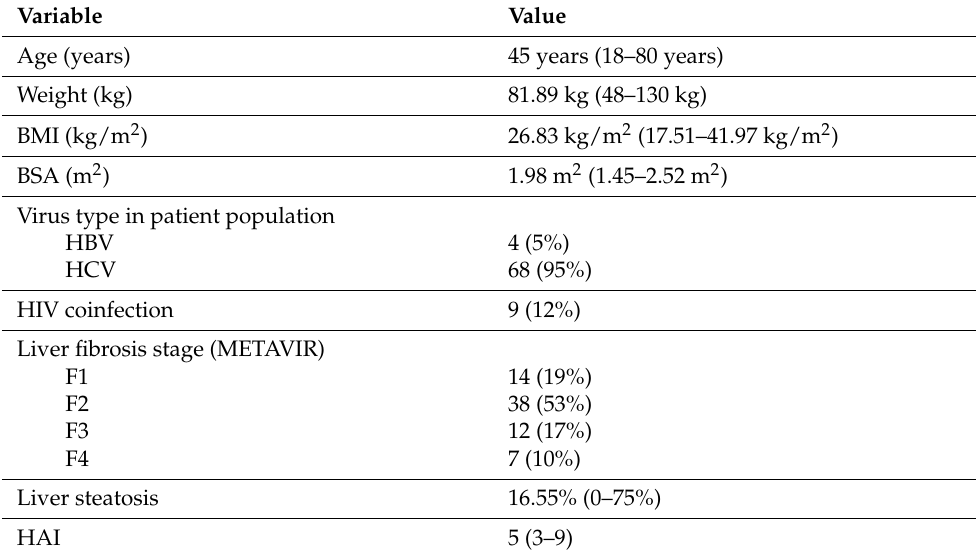
Table 2. Clinical characteristics of study